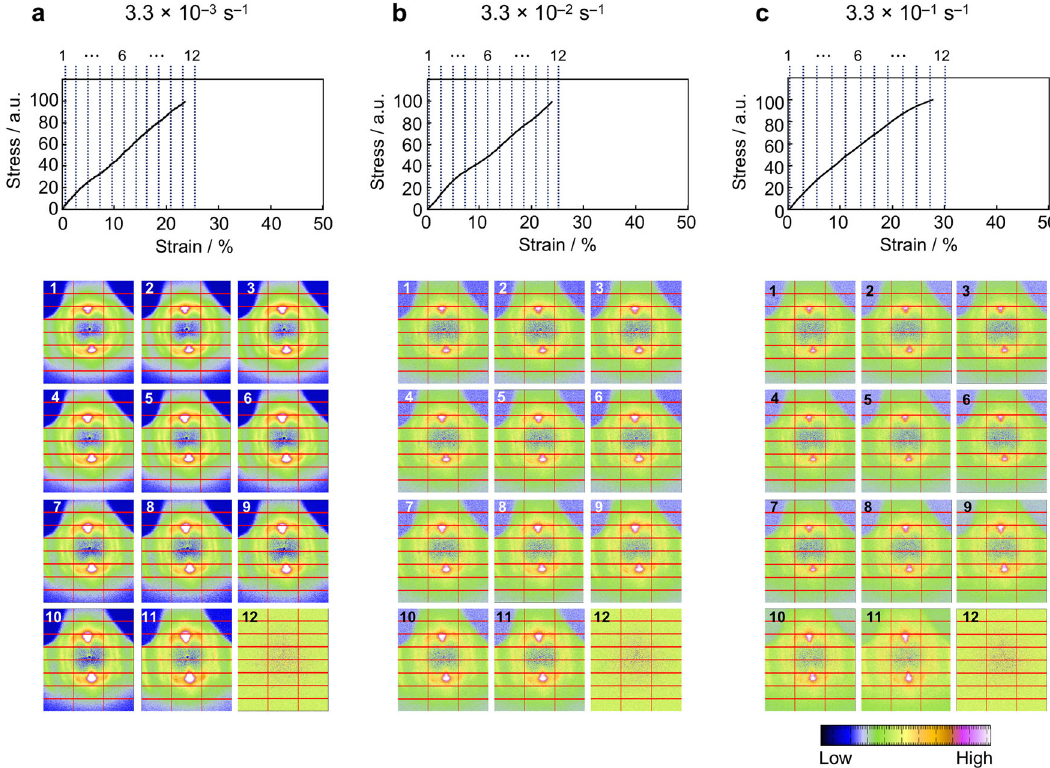
Fig. 8 Structural analysis of spider draglien upon extension. Two-dimensional WAXS pro fi les at strain rates of a 3.3 × 10 − 3 s − 1 , b 3.3 × 10 − 2 s − 1 , and c 3.3 × 10 − 1 s − 1 using spider dragline silk fi bers at RH43%. The simultaneous WAXS-tensile tests prevented us from making a composite image from the resultant WAXS data. Thus, the boundary of each camera detector remained in the overall scattering images because the single detector could not detect all the scattering of whole sample areas. The boundary of the camera detector is masked, which is highlighted by red